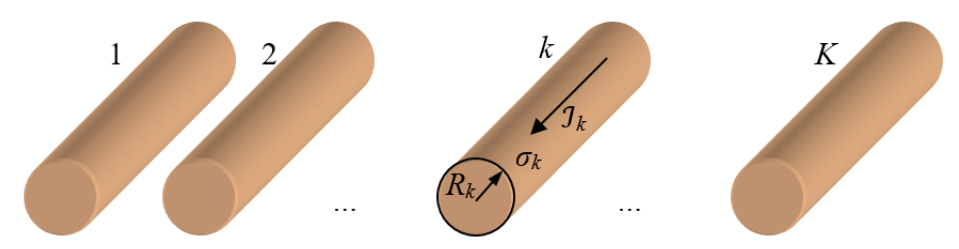
Figure 1. Multi-wire bus duct with round parallel wires.